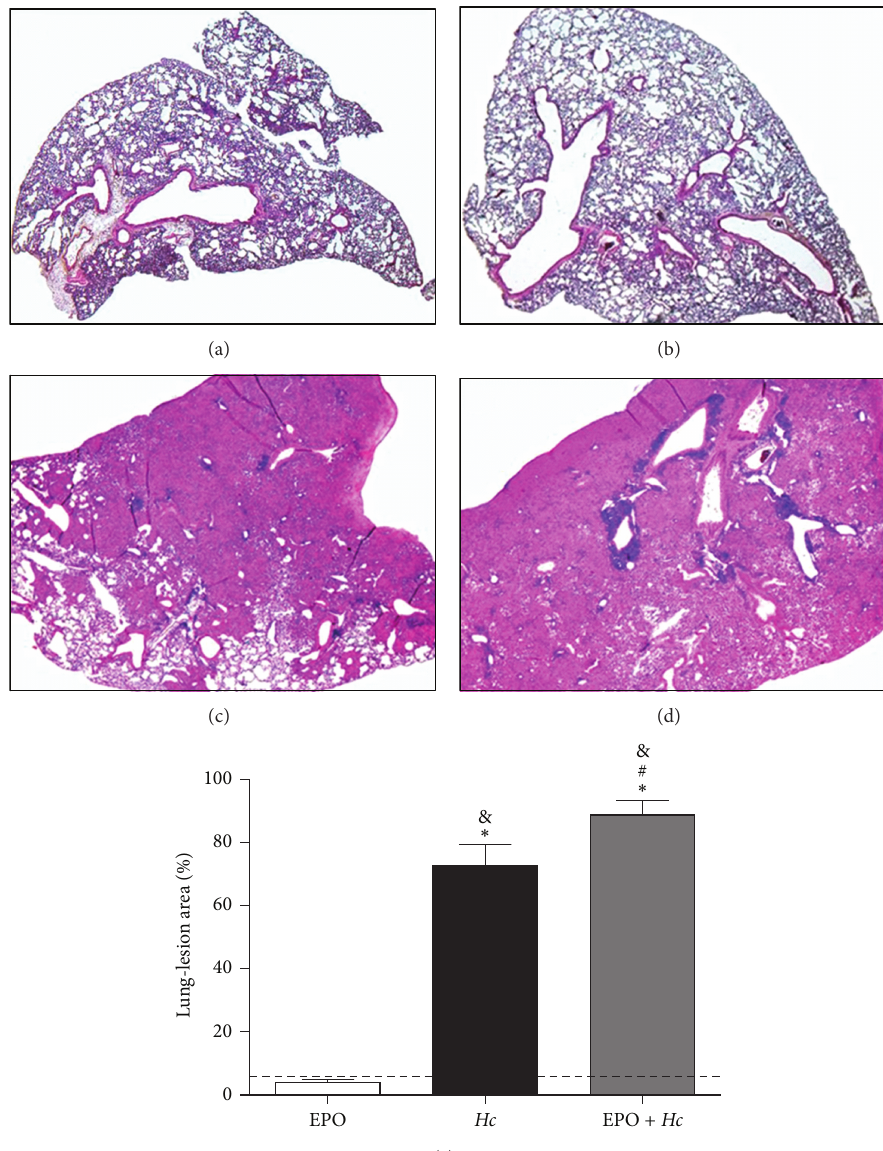
Figure 7: EPO pretreatment increases the area of lung tissue damage in Hc -infected mice. Lungs removed from uninfected and untreated mice (CTL) (a), EPO pretreated and uninfected mice (EPO) (b), Hc- infected only ( Hc ) (c), and EPO pretreated mice infected (5 × 10 5 yeasts/100 𝜇 L/mouse) ( EPO + Hc ) (d). Lungs were removed 14 days after infection, processed, and stained using H&E for routine histological examination. (e) Lung-lesion area was calculated by measuring three lungs per group and was expressed as total lung area using Adobe Photoshop. Mean ± SEM values from one independent experiment are shown. Representative photomicrography of lung of one animal per group from 𝑛 = 4 –6. Newman-Keuls multiple comparison test was used and the differences were considered significant when 𝑝 < 0.05 . # Versus Hc ; ∗ versus CTL (dashed line); & versus